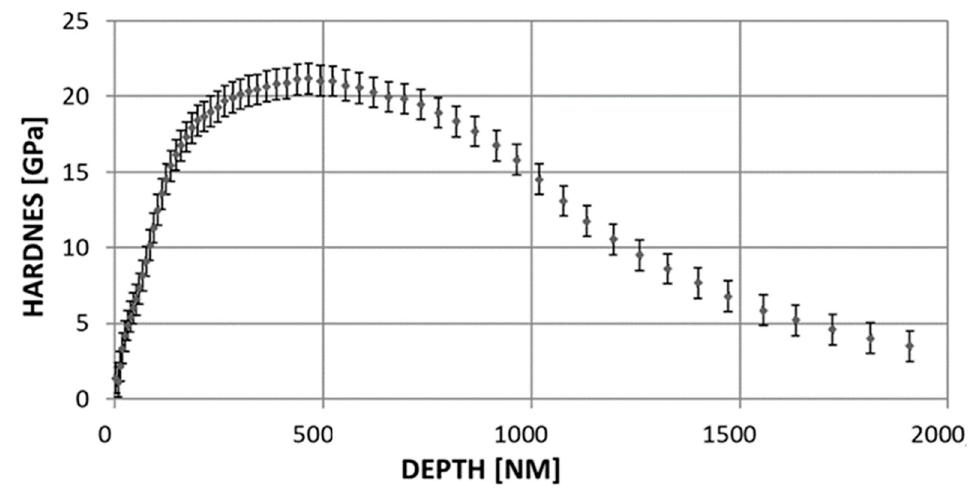
Figure 4. Hardness in the function of the depth of the forced-in penetrator.